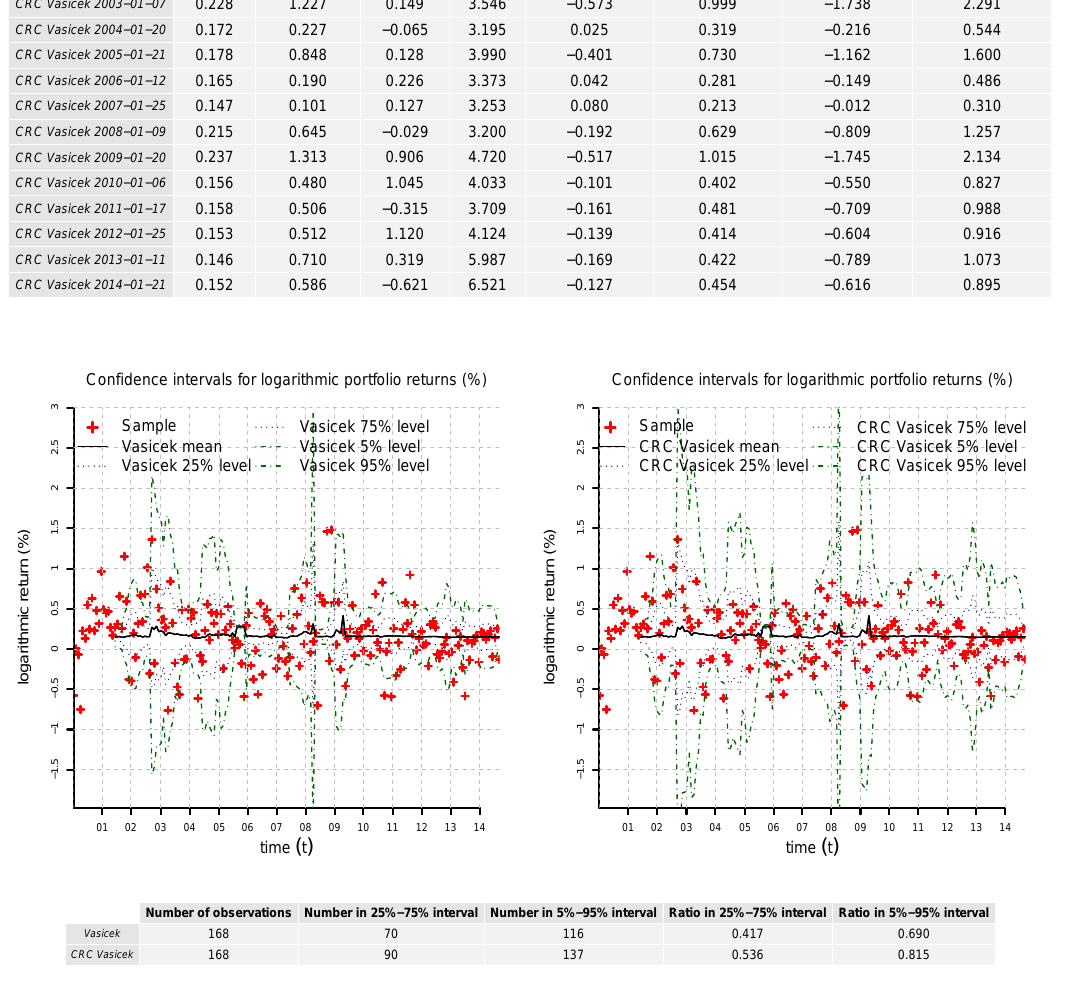
Figure 20. Confidence intervals computed from 10 4 simulations of the test portfolio returns in the Vasiˇcek model and its CRC counterpart with stochastic volatility. For each monthly period, we check if the market return lies in the confidence interval. This is more often the case for the CRC than for the standard Vasiˇcek model. A one-sided binomial test assuming the independence of monthly periods shows that the difference is statistically significant ( p = 0.0013 for the 25% and p = 0.00017 for the 5% quantiles). The result remains significant if every second month is discarded to account for dependencies ( p ≈ 0.01). This suggests that the CRC Vasicˇek model is able to match the return distribution better than its counterpart with constant